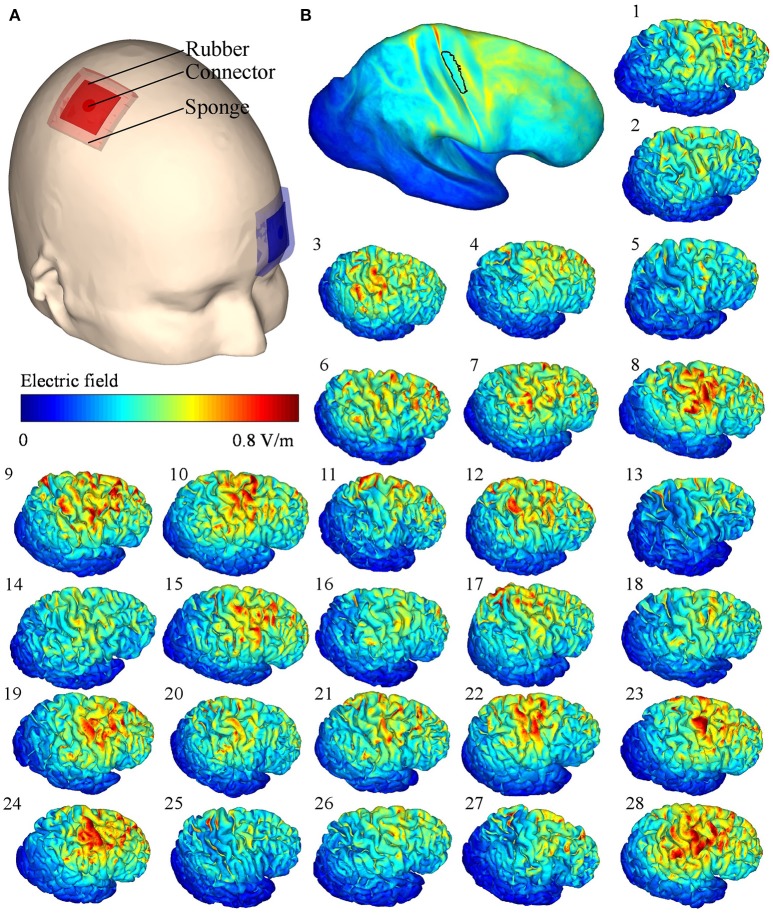
(A) Transcranial direct current stimulation (TDCS) electrode locations on the scalp. (B) Mean of the electric fields (EFs) mapped onto the Montreal Neurological Institute template, the black outlined area represents the region of interest; (1–28) simulated TDCS EFs of each subject on the right hemisphere.